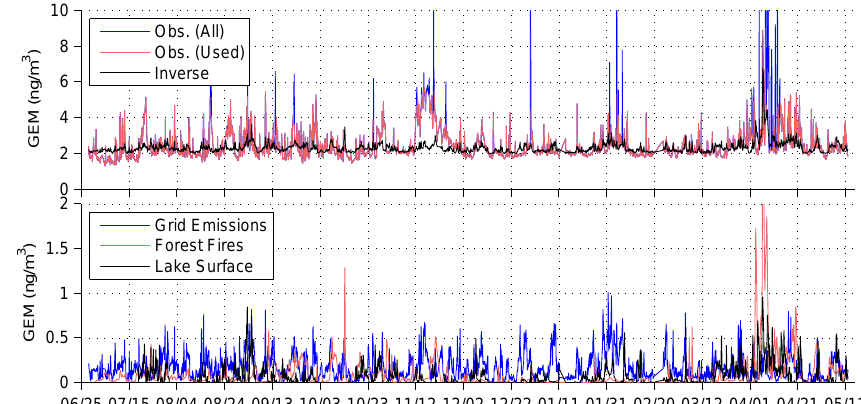
Fig. 10. Top: Measurements used in inversion (red), measurements excluded using residucal scaling (blue), and inverse time series of GEM. Bottom: Concentration contributions to the inverted time series of the grid, forest fire and lake surface emissions, June 2004 to May